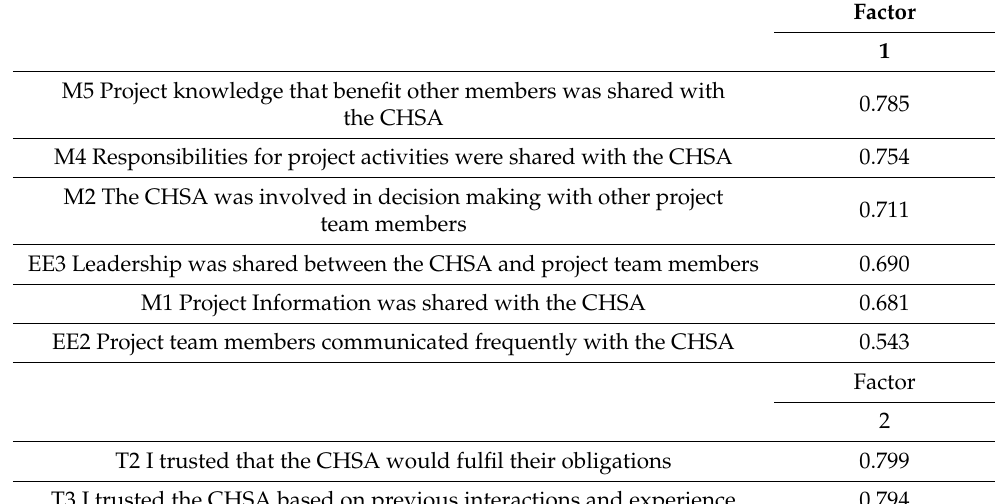
Table 5. Rotated factor